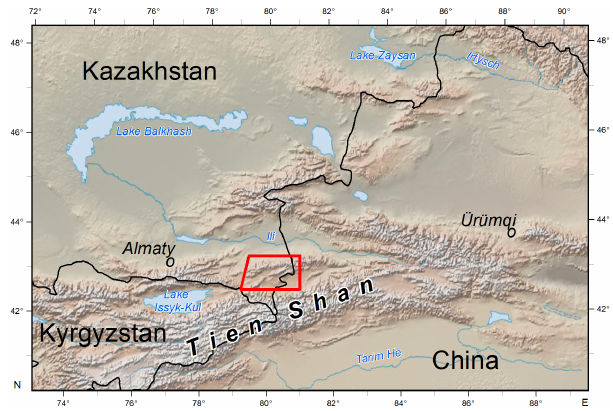
Figure 1. Map overview showing the investigation area detailed (trapezoid) in central